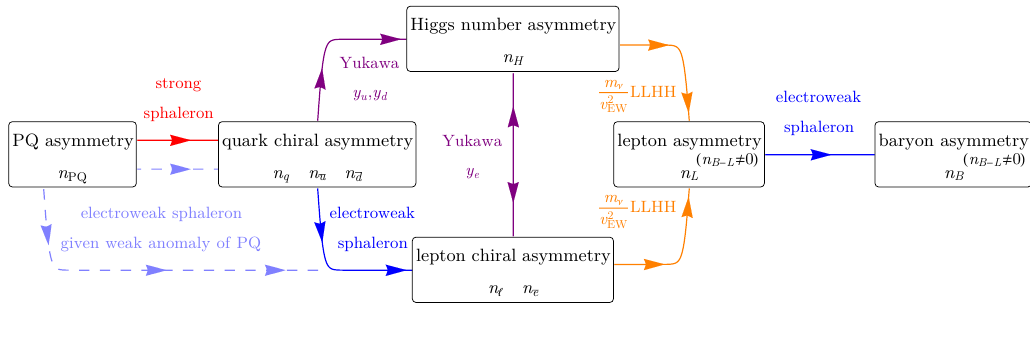
Figure 2 . Transfer of asymmetries for lepto-axiogenesis for the scenario